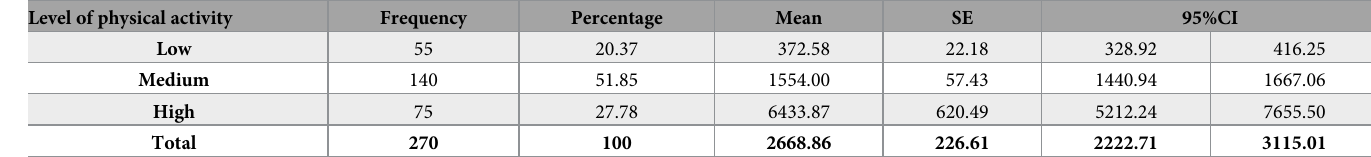
Table 2. Different levels of physical activity with mean, SE and 95% CI of MET values among urban diabetic patients in Nepal (n = 270).